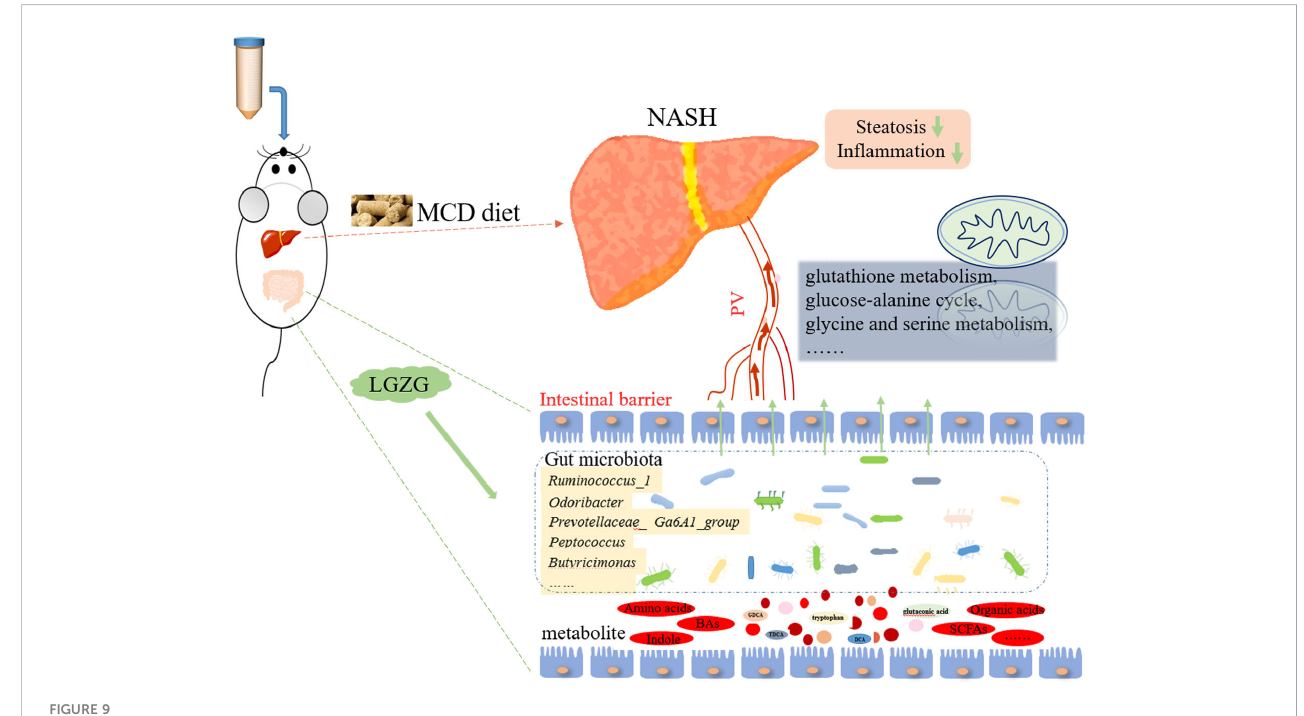
FIGURE 9 Potential mechanisms of LGZG against